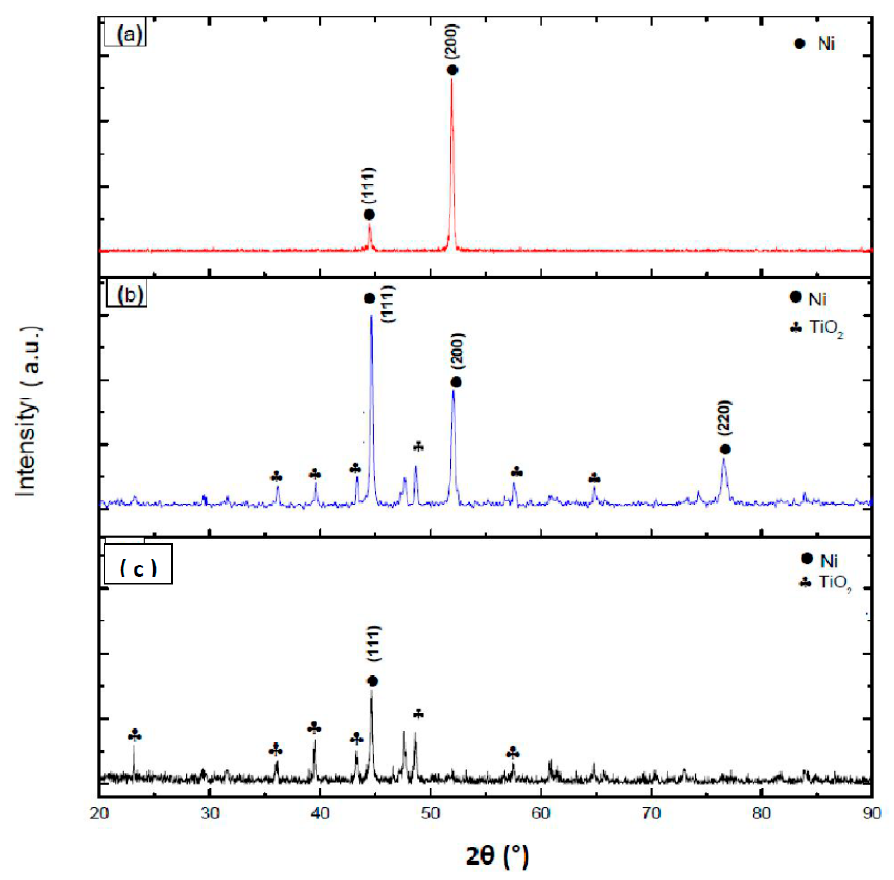
Figure 3. X-ray patterns of the electrodeposited Ni on copper ( a ) without and with the addition of TiO 2 , ( b ) 5 g/L of TiO 2 , ( c ) and 10 g/L of TiO 2 .